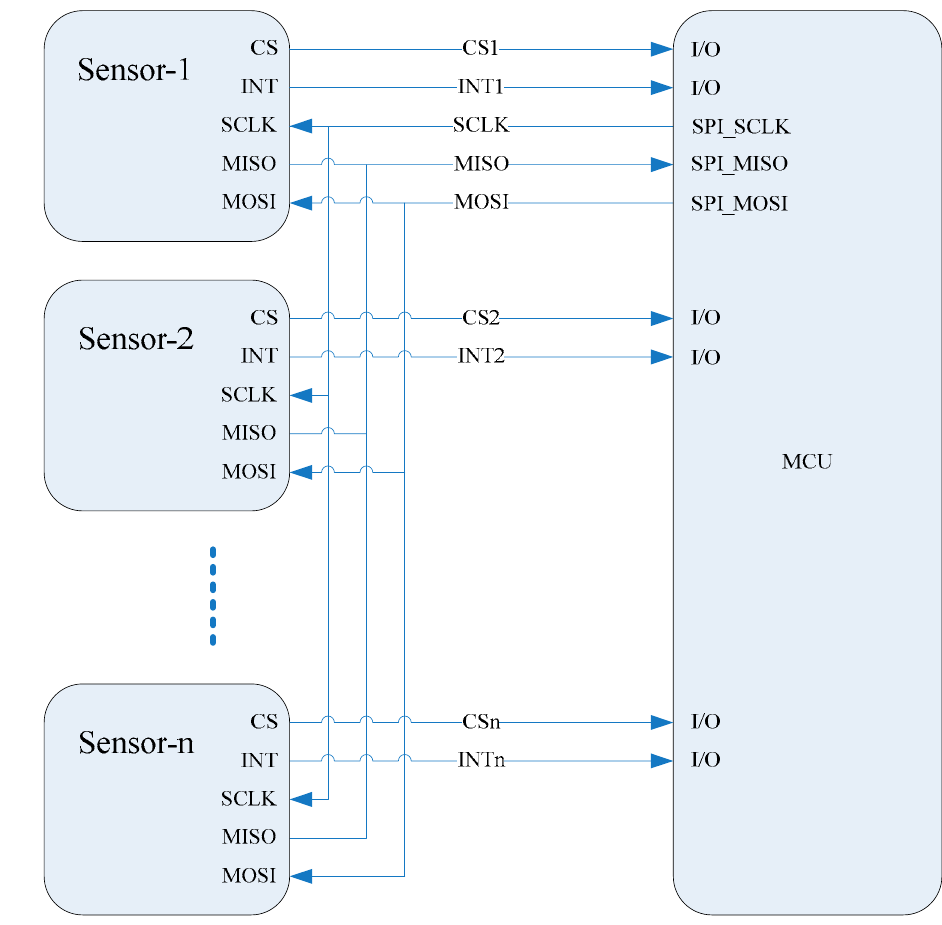
Figure 2. Schematic diagram of the sensors in our instrument, connected in parallel.